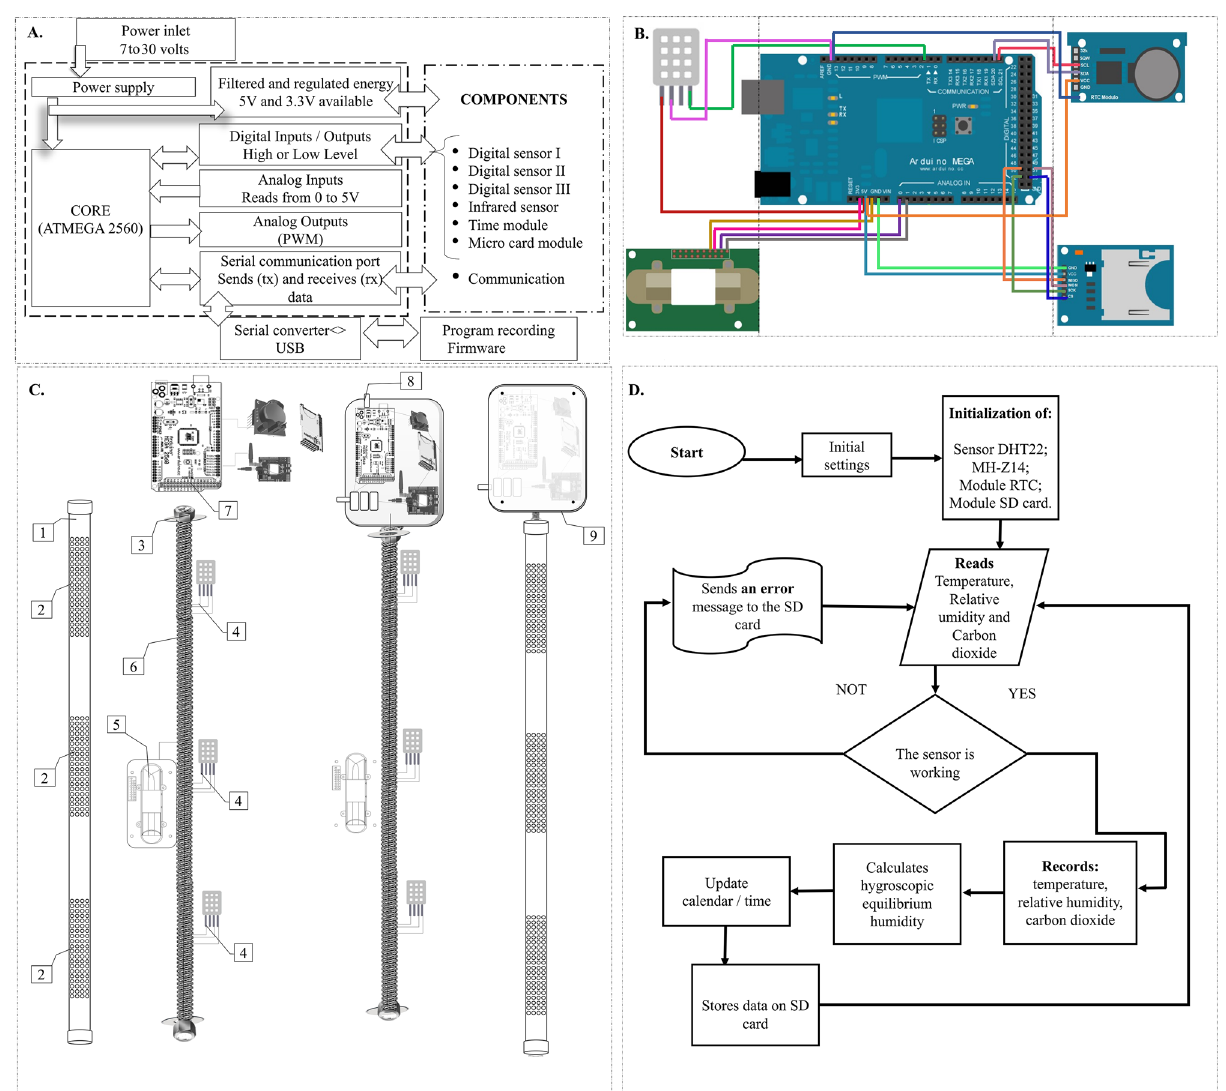
Figure 1. Block diagram of the monitoring operating system ( A ). Connection of the components to the microcontroller using jumper cables ( B ). Structural part of the probe for application in the grain mass ( C ), where: 1- polyvinyl chloride tube, 2—holes for air entry, 3—fixing elements, 4—DHT22 sensors, 5—MH-Z14 sensor, 6—threaded bar and support cabling, 7—equipment hardware, 8—internal view of the probe, 9—probe for application in the grain mass. Flowchart of the programming used for the operation of the monitoring system ( D ditions (Figs. 2B,C). Filling of each load was performed using grains with 12 and 14% moisture content. Samples were collected at 0, 120, 480, and 1440 min of transport at the three positions (higher, center and lower) of the